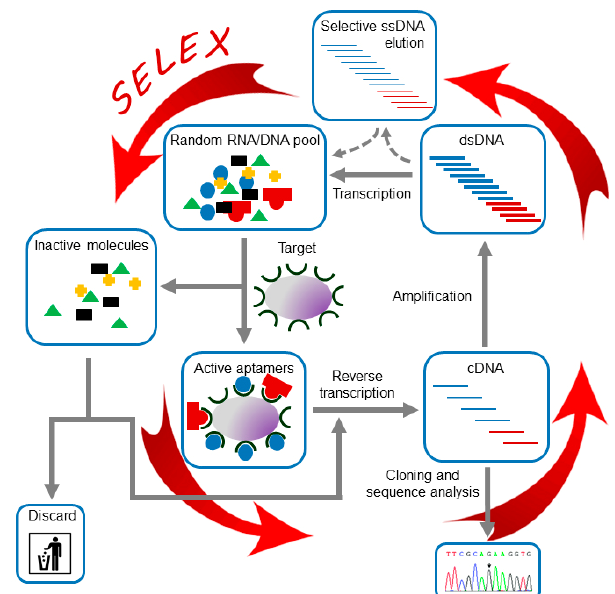
Figure 2. SELEX procedure. The figure shows a general scheme of the RNA aptamer in vitro selection process. Broken lines indicate the alternative steps required for the selection of DNA aptamers.